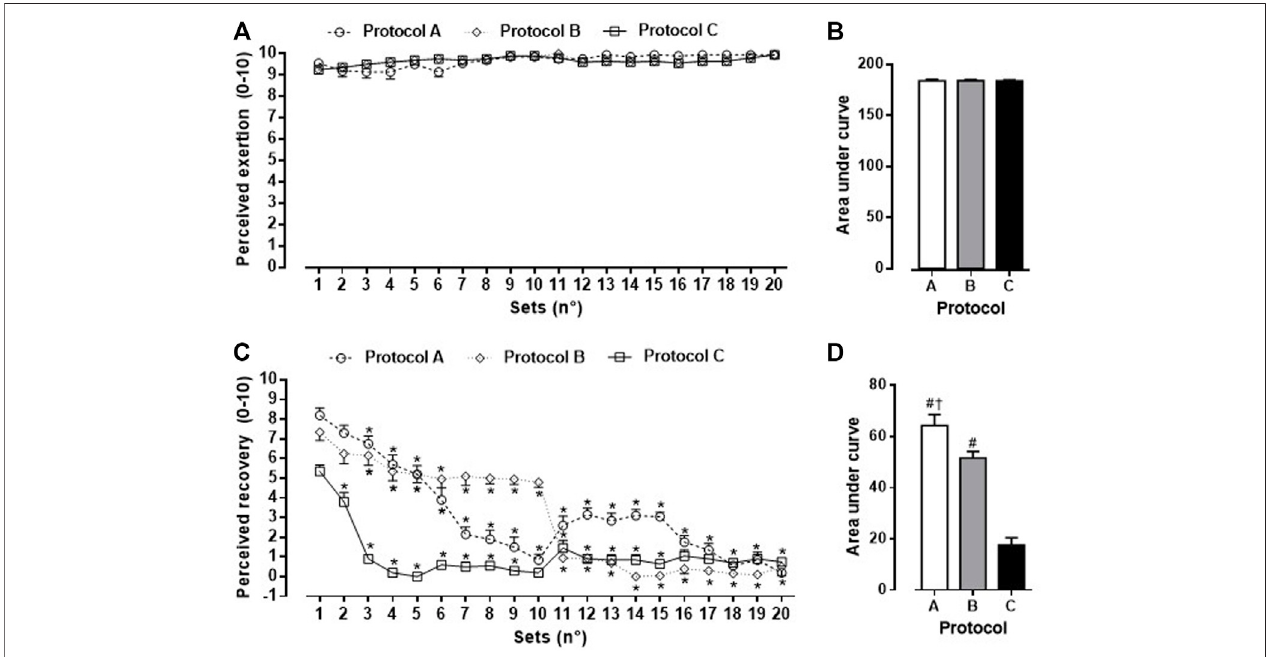
FIGURE 2 | Values expressed as mean ± DP for perceived exertion around set [Panel (A) ], area under curve for perceived exertion [Panel (B) ], perceived recovery aroundset [Panel (C) ]and areaundercurve for perceived exertion [Panel (D) ] forprotocol A(jumping jack,burpee, mountain climband squat jump), protocol B(jumping jack,mountain climb, burpee, and squatjump)and protocolC(burpee,squat jump,jumpingjackand mountain climb). * p < 0.001vs. First set. # p < 0.001vs. protocolC † p < 0.001 vs. protocol B.